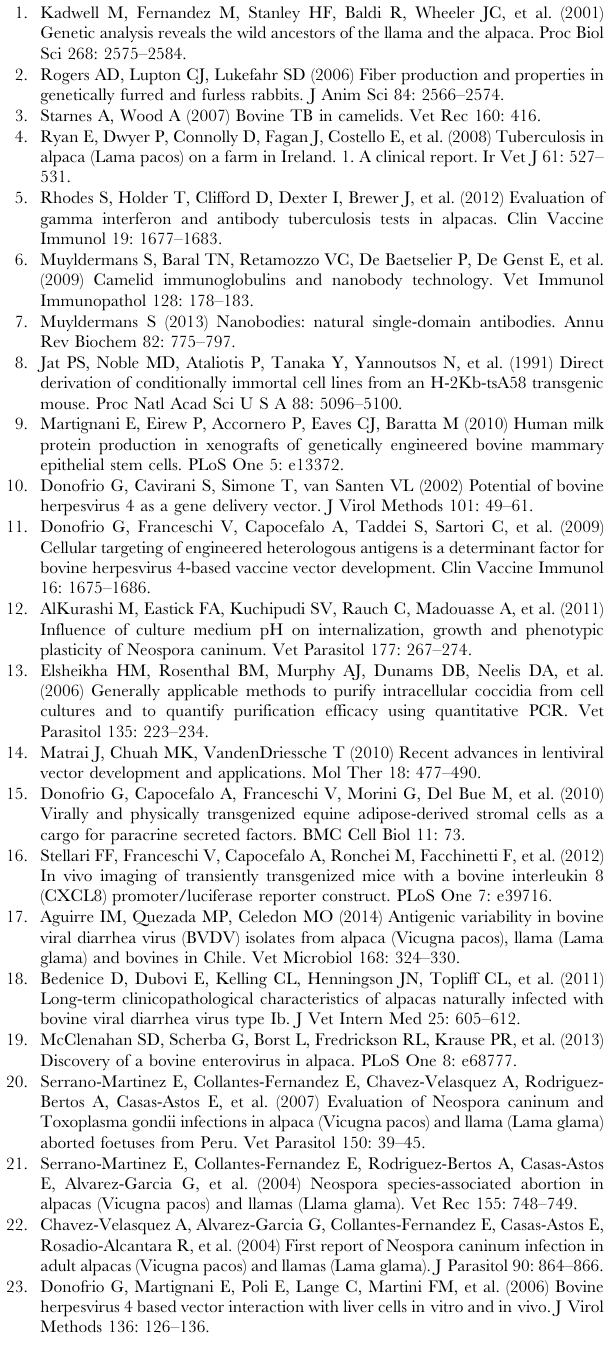
Figure 8. Invivo tumorigenesis assay. A) Representative in vivo bioluminescence images of nude mice subcutaneously inoculated with 3 6 10 6 lentiviral transduced ASSCs on one side and 10 6 on the opposite side of their body. Luminescence signal was acquired weekly until it was no